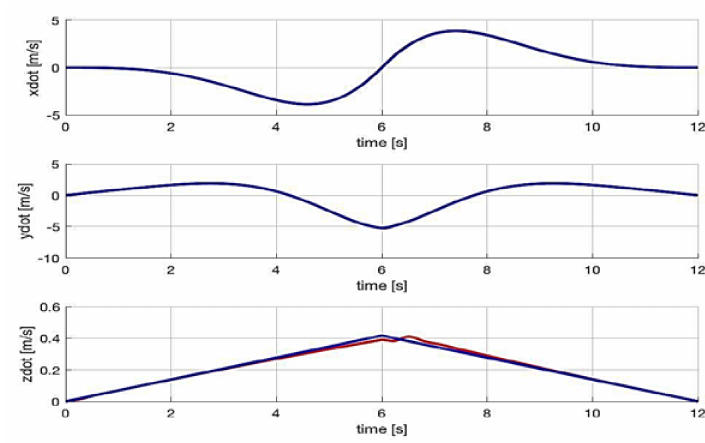
Figure 15. Linear velocity responses while circular trajectory